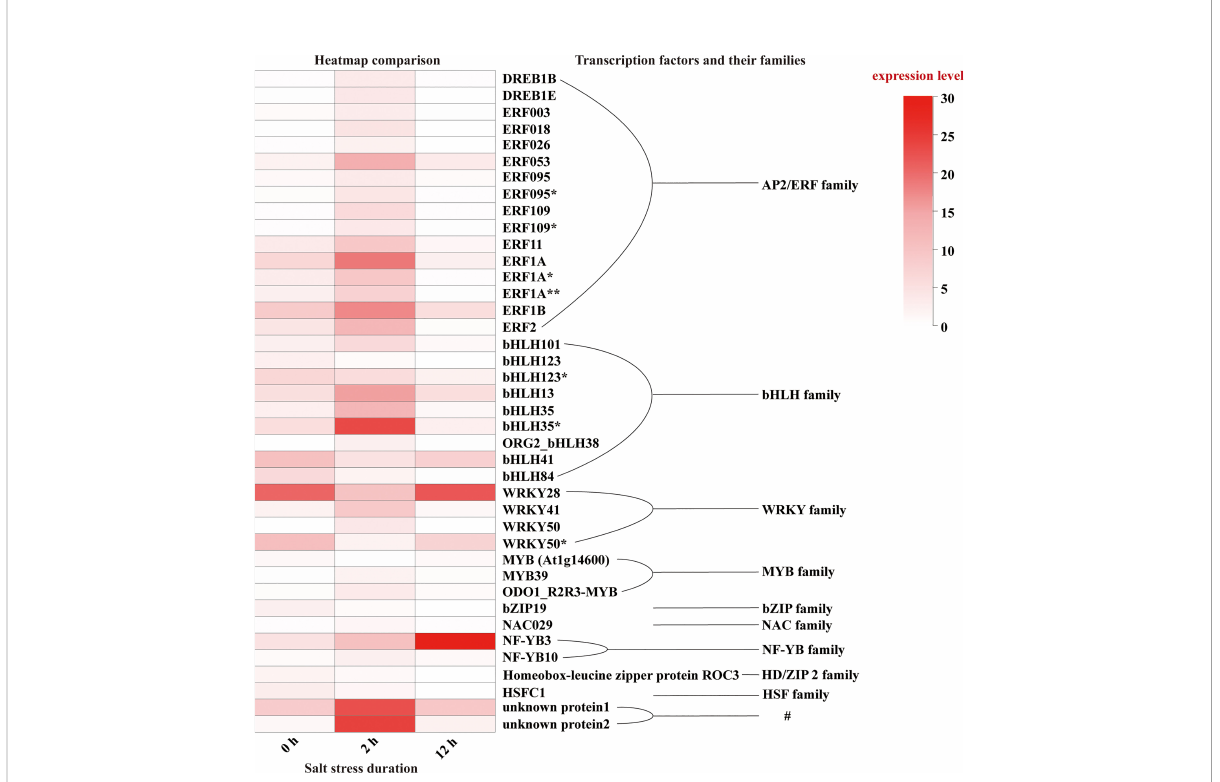
FIGURE 10 Expression pattern of the transcription factors identi fi ed in DEGs. “ * ” indicates the identical gene ID but different species and “ # ” means that they have DNA-binding transcription factor activity although they were unknown